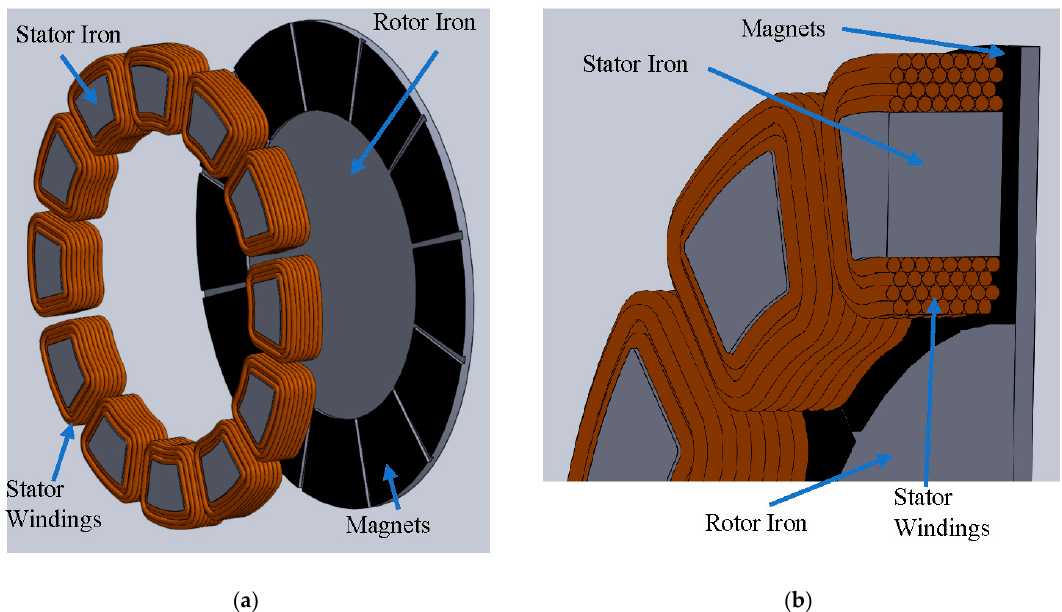
Figure 3. CAD illustration of an axial flux permanent magnet electric motor: ( a ) exploded view of rotor and stator, and ( b ) axial cross-section of the axial flux permanent magnet motor.